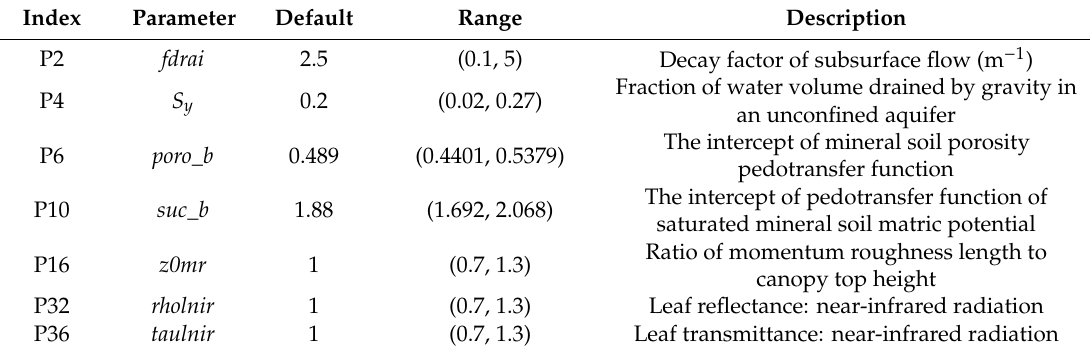
Table 1. List of sensitive parameters for the evapotranspiration simulation in the Community Land Model version 4.0.